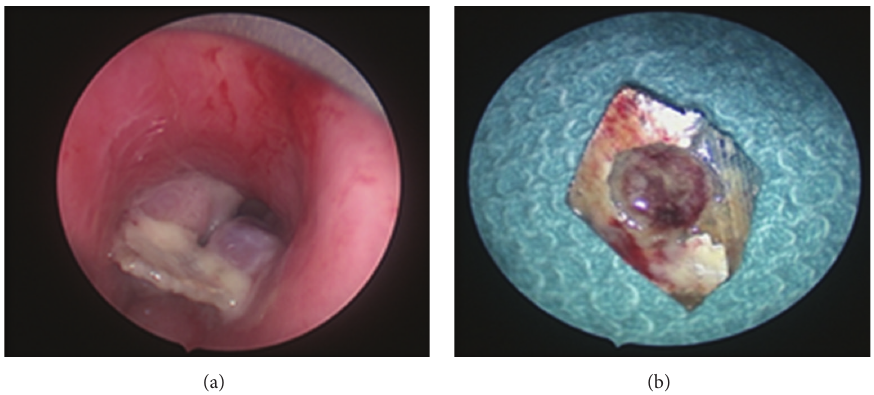
Figure 3: Tablet foil with surrounding granulation